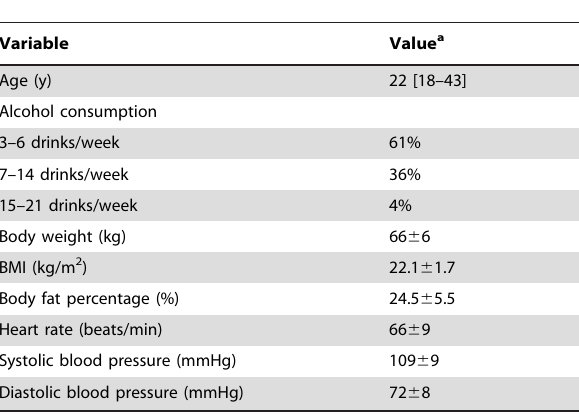
Table 1. Baseline characteristics of the participants (n=